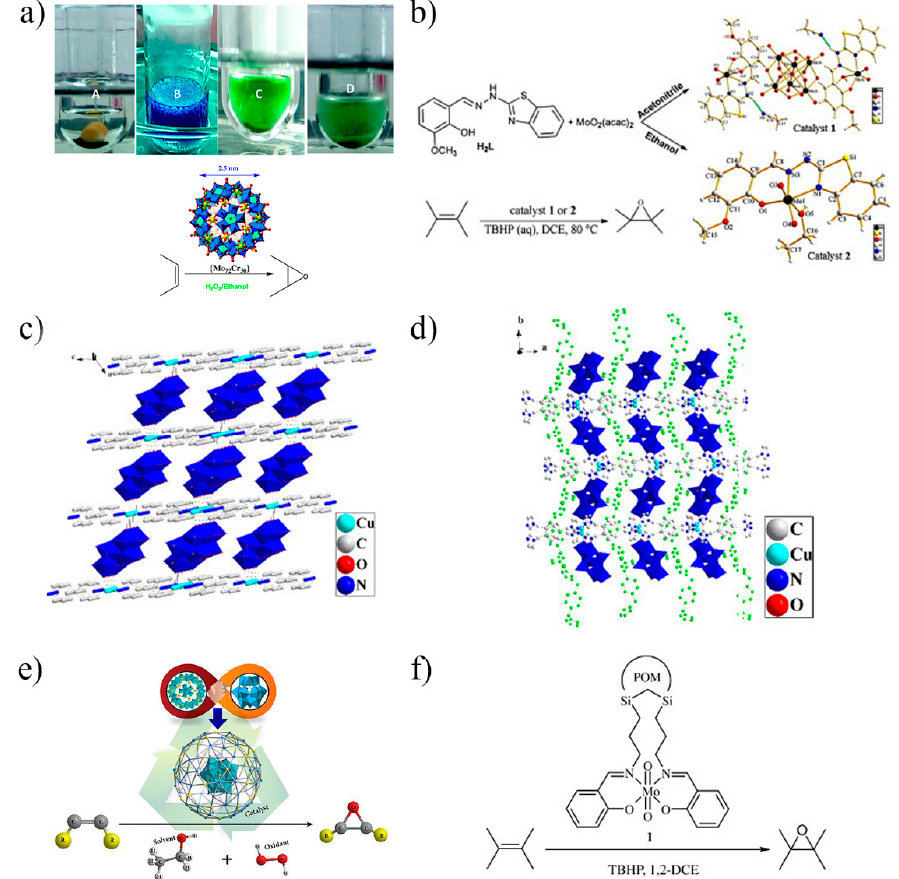
Figure 1. ( a ) Photographs of epoxidation process using {Mo 72 Cr 30 } as catalyst. Reproduced